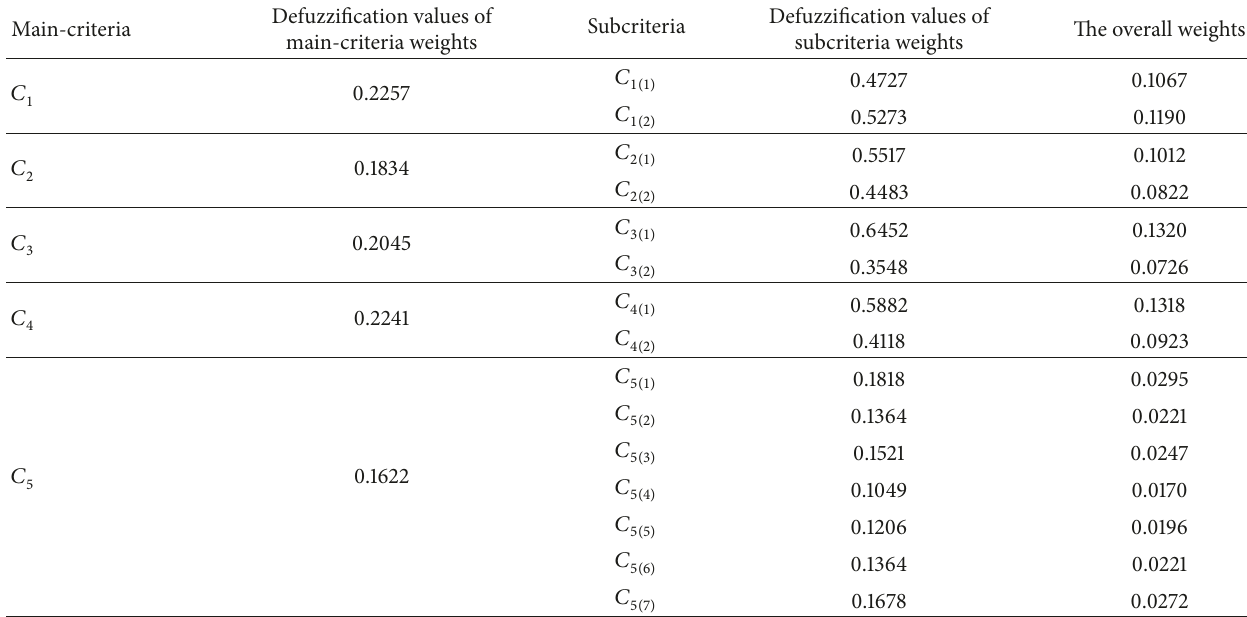
Table 5: The defuzzification values of the criteria weights as well as the overall weights.